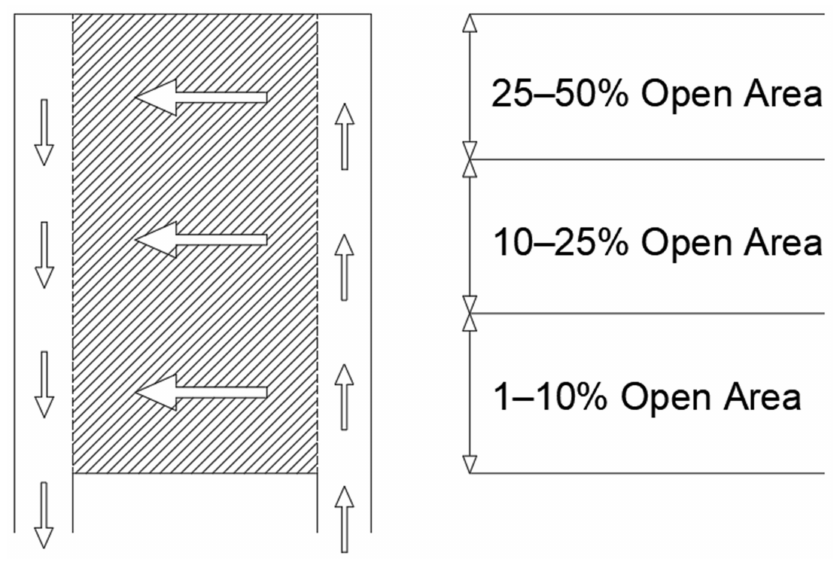
Figure 1. Celik’s research results in the form of openings